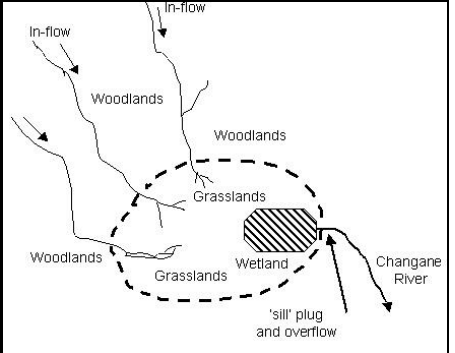
Fig. 2. Schematic representation of the endorheic wetland system of the Parque Nacional de